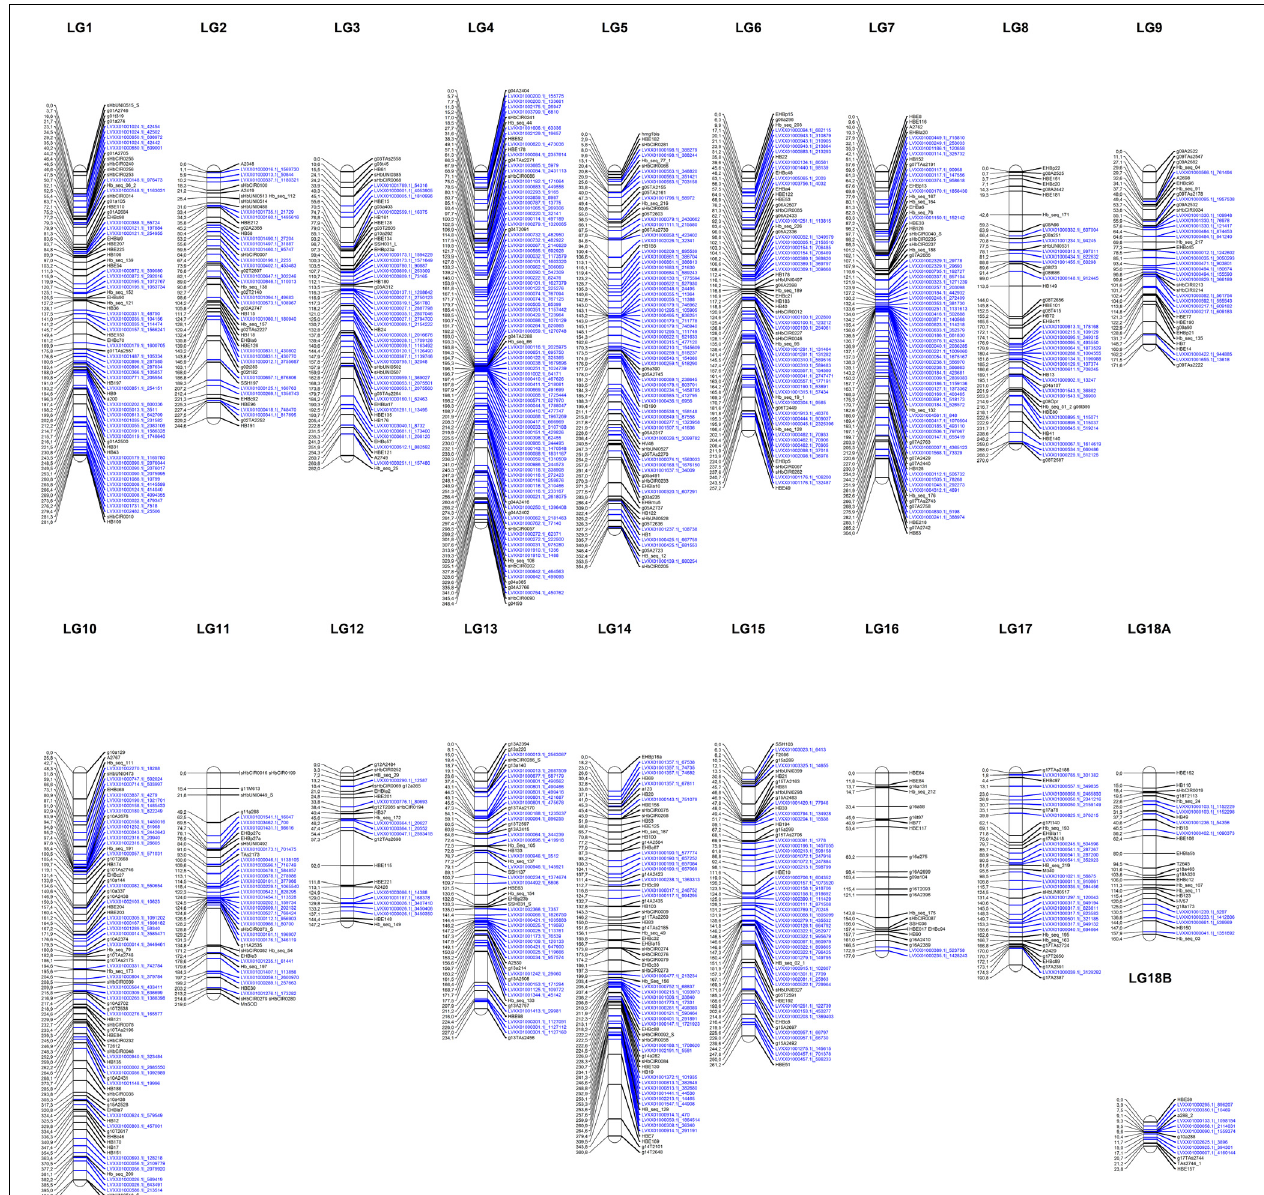
FIGURE 1 | Linkage map of the rubber tree. Markers in blue represent SNPs obtained using the genotyping-by-sequencing technique, and markers in black were obtained from the previous map (Rosa et al.,